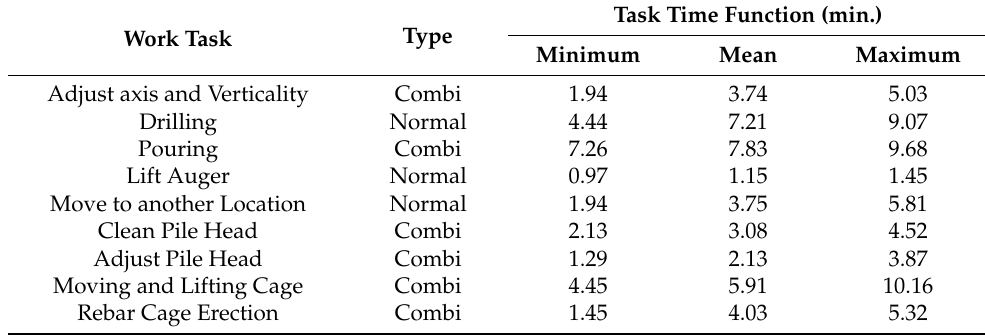
Table 5. Task time function for work tasks.